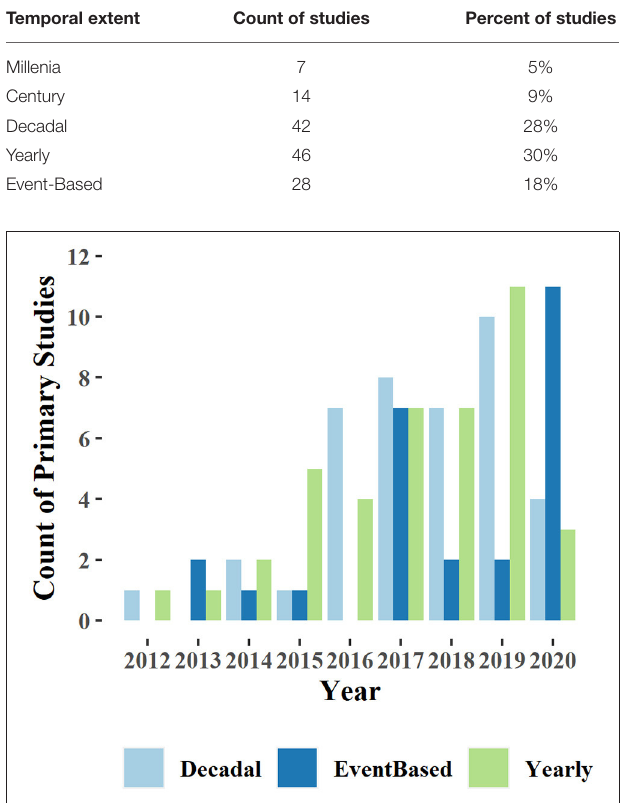
FIGURE 3 | Count of the primary studies’ three most common temporal extents by year of publication between 2012 and